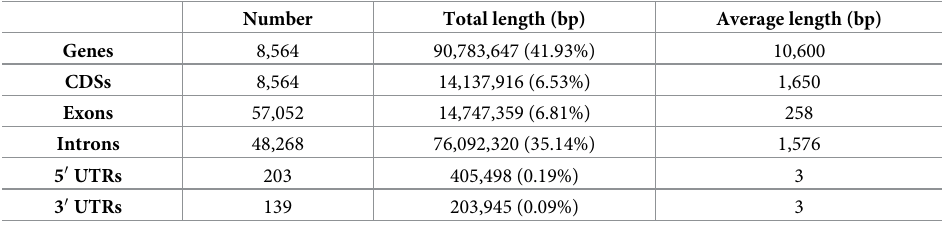
Table 3. Gene prediction statistics of the Cardicola forsteri genome